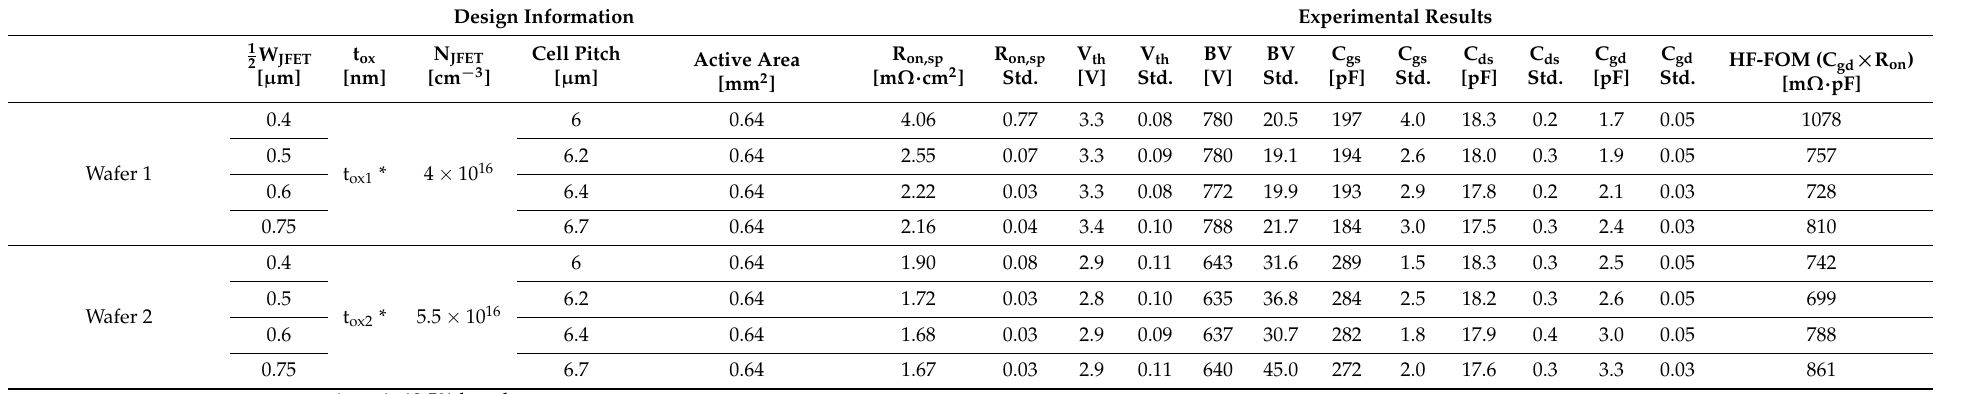
Table 1. Summary of design information and experimental